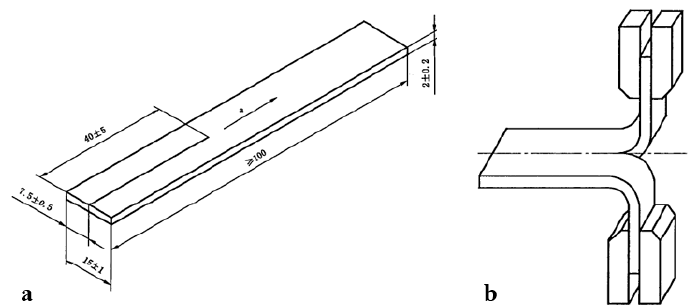
Figure 3. ( a ) Trouser tear test specimen during unloading stage (length 100 mm, width 15 mm, thickness 2 mm, pre-cut 40 mm), and ( b ) the trouser tear specimen during loading stage.